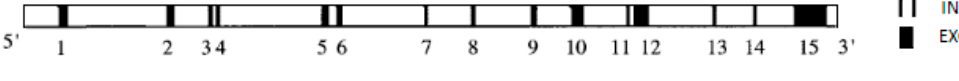
Figure 6. Structure of the human HIF1A gene.